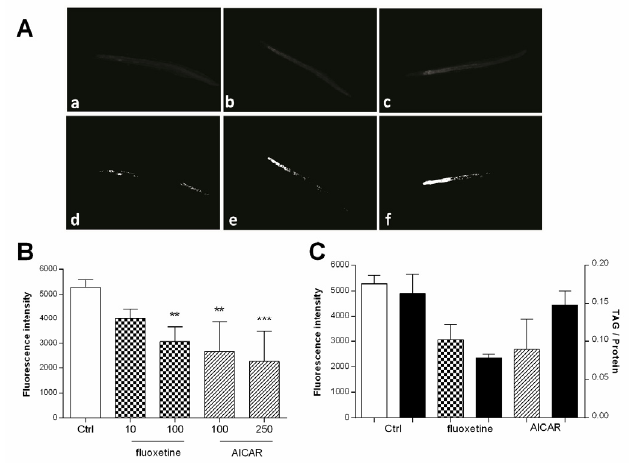
Figure 7. ( A ) Representative images of worms treated with ( a ) fluoxetine (100 µ M), ( b ) fluoxetine (10 µ M), ( c ) vehicle control (1% DMSO), and their corresponding areas measured after binarization ( d – f ) ( B ) Bar charts represent the mean Nile red fluorescence of worms from three independent experiments ( ± SD). Worms were treated with Ctrl (vehicle control, 1% DMSO), fluoxetine (10 µ M and 100 µ M), and AICAR (100 µ M and 250 µ M). The significance was assessed by one-way ANOVA and Bonferroni post-test (** p < 0.01, *** p < 0.001). ( C ) White bars represent either Nile red fluorescence ( n = 3; ±SD) compared to black bars representing extracted and biochemically quantified TAG content of worms relative to protein content ( n = 2; ±SD). Worms were treated with Ctrl (vehicle control, 1% DMSO), fluoxetine (100 μ M), and AICAR (100 μ M).